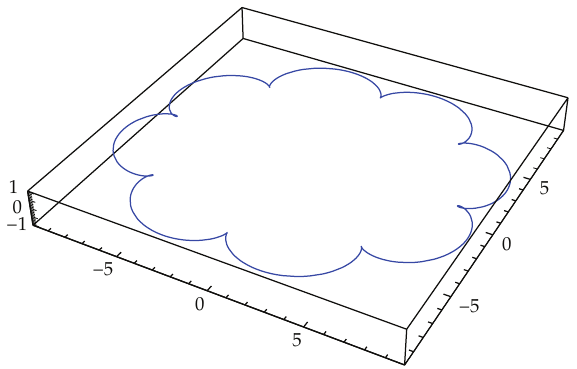
Figure 27: The evolution of the spiky type solution (cid:2) 5.10 (cid:3) with n (cid:6) 10 , α (cid:6)